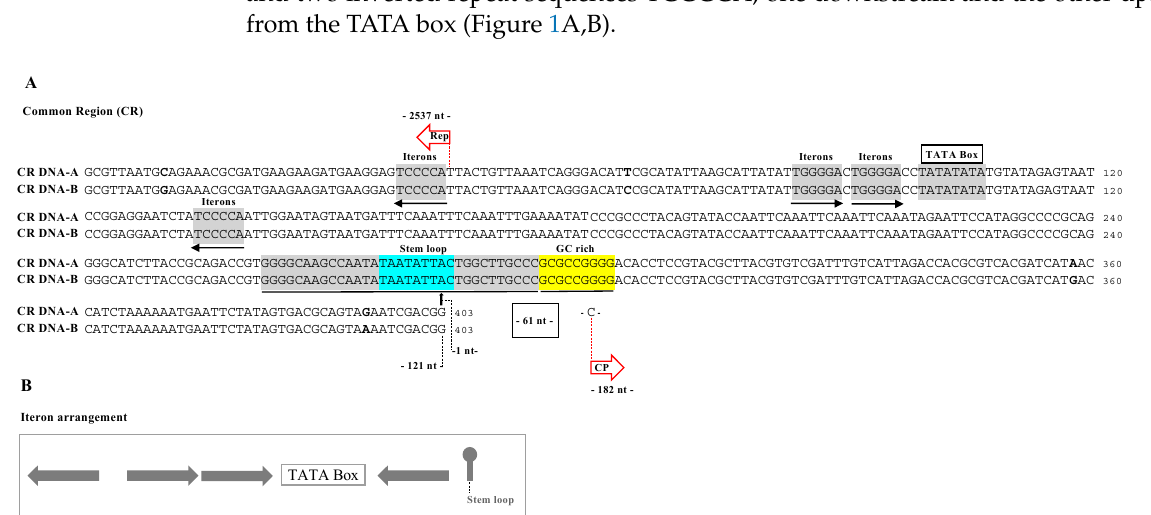
Figure 1. ( A ) Common region of OEGV-PT DNA-A and DNA-B alignment (5 ′ –3 ′ ). Iterons and complementary iterons sequences are shown in gray, black arrows indicate their relative orientation; TATA box is shown in gray; the nonanucleotide sequence is shown in blue together with the sequences with the potential to form a stem-loop structure (in gray) to the right and to the left. The differences in the nucleotide sequences between both OEGV-PT DNAs (A and B) are shown in bold. The ↓ (black arrow) indicates position 1 in the viral genome corresponding to the predicted replication origin of the viral DNA. GC rich region in shown in yellow. ( B ) Iterons arrangement in OEGV-PT DNA-A and DNA-B alignment (5 ′ –3 ′ ) positioned in relation to the TATA box and stem loop. Gray arrows indicate two iterons (virion-sense) and two complementary iterons (complement-sense).